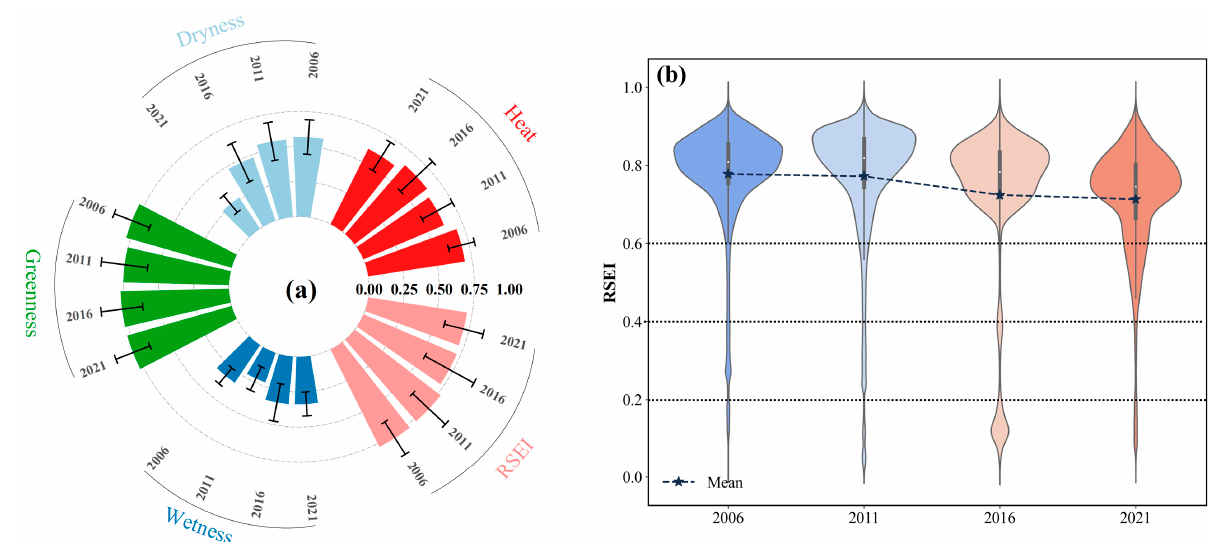
Figure 4. ( a ) Four factors and ( b ) RSEI statistics for 2006–2021.